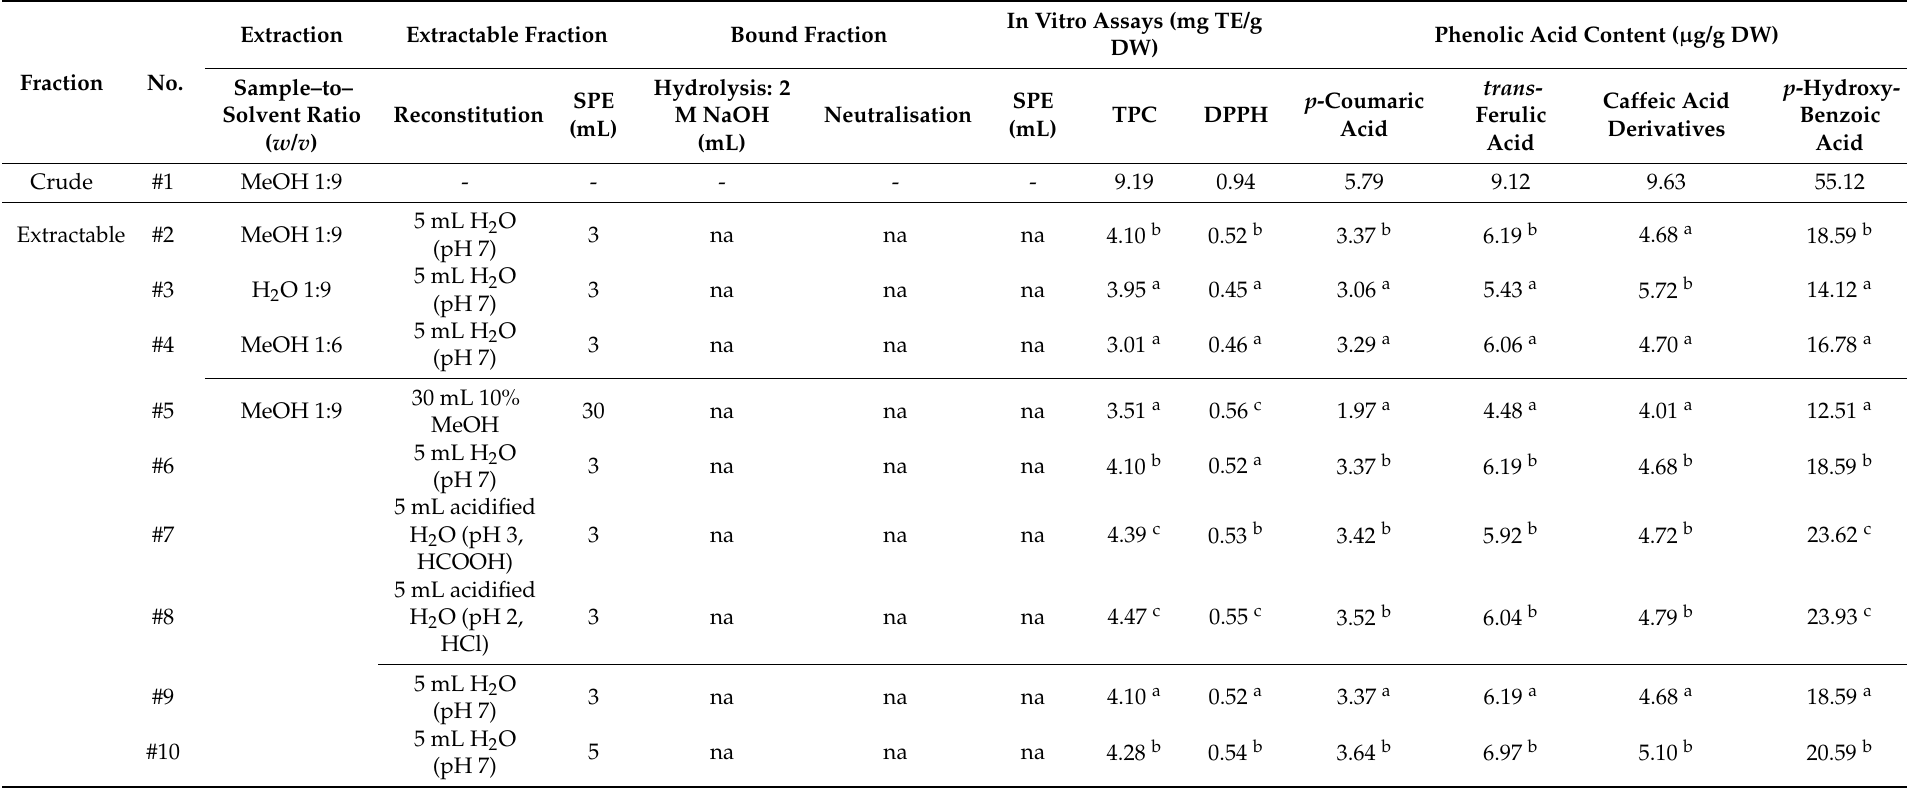
Table 1. Effects on total phenolics content (TPC), DPPH • scavenging activity (DPPH) and individual phenolic acid content for the different protocols for the extractable and bound phenolics of the germinated spelt